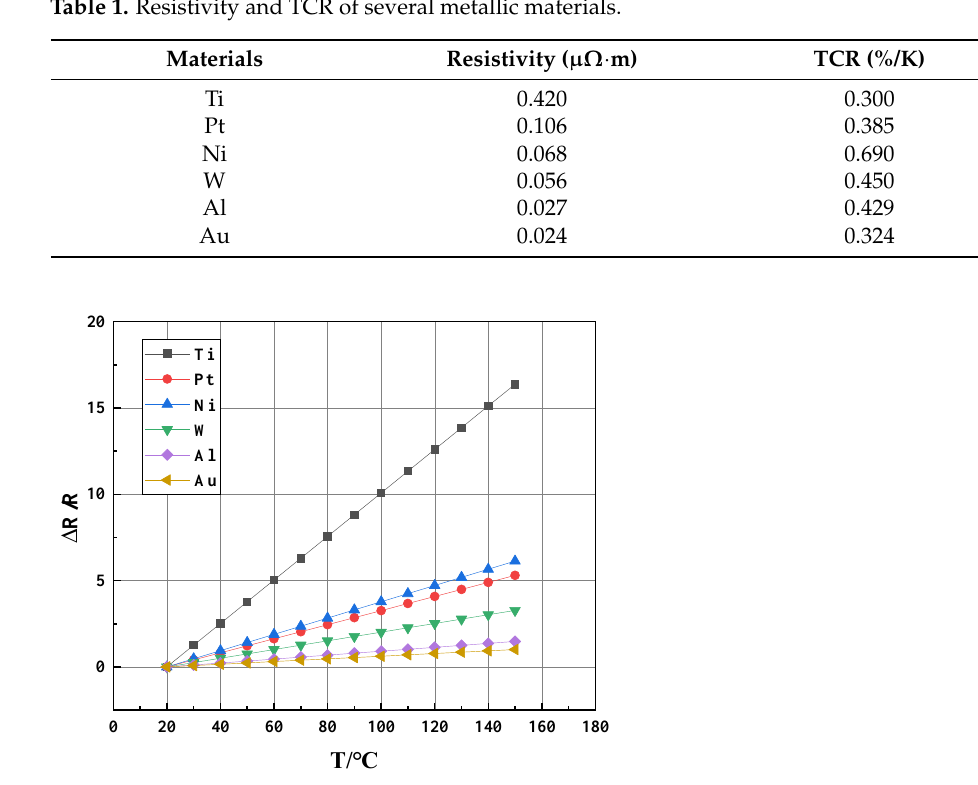
Figure 3. Change rate of resistance of several metals with temperature.